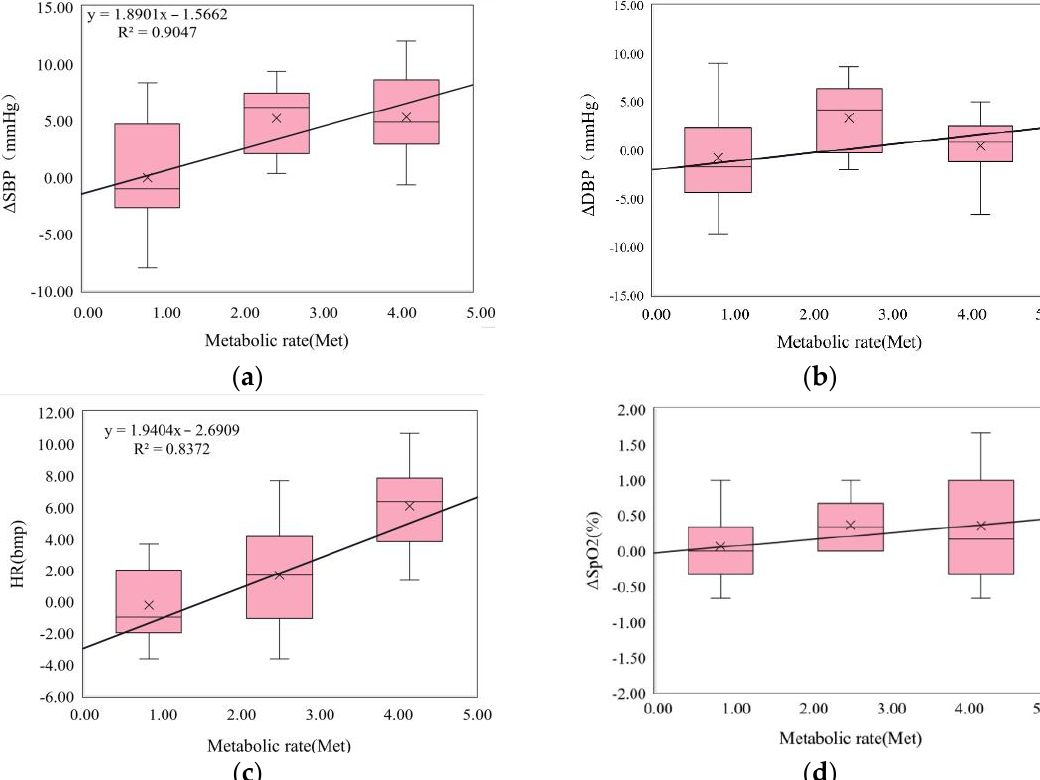
Figure 9. ΔSBP, ΔDBP,ΔHR, and ΔSpO2 in relation to metabolic rates (ΔSBP ( a ), ΔDBP ( b ), ΔHR ( c ), and ΔSpO2 ( d )).